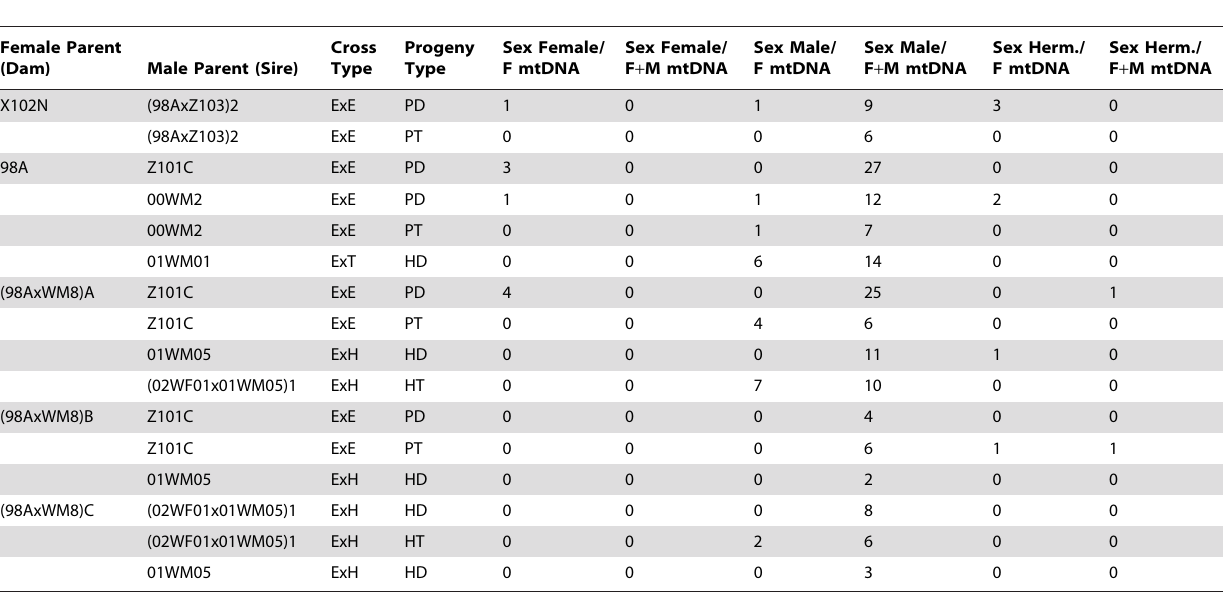
Table 3. Number of Progeny by Sex and Mitotype from Pure and Hybrid Crosses of Diploid and Triploid Mytilus Produced from Mothers Known to Produce Male-Biased Progeny.